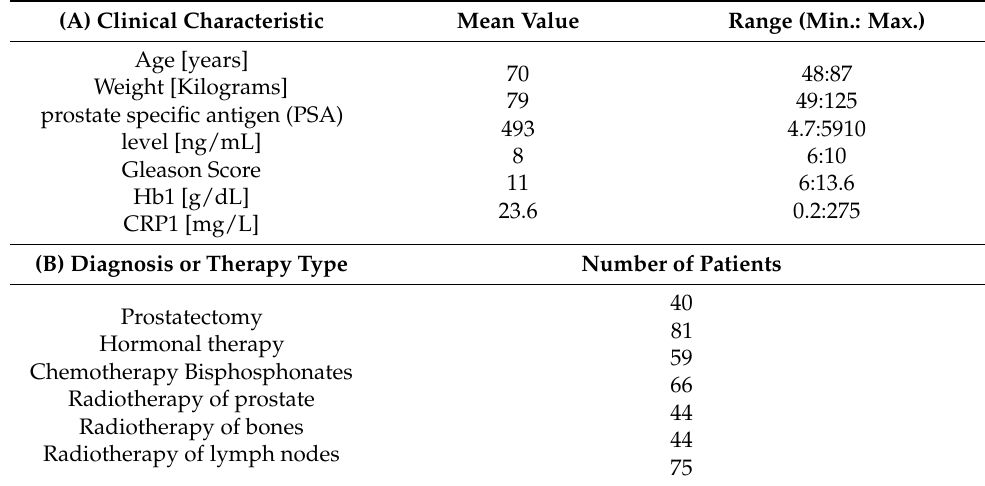
Table 3. ( A ) Mean values and ranges of the clinical parameters and ( B ) the therapy information of the